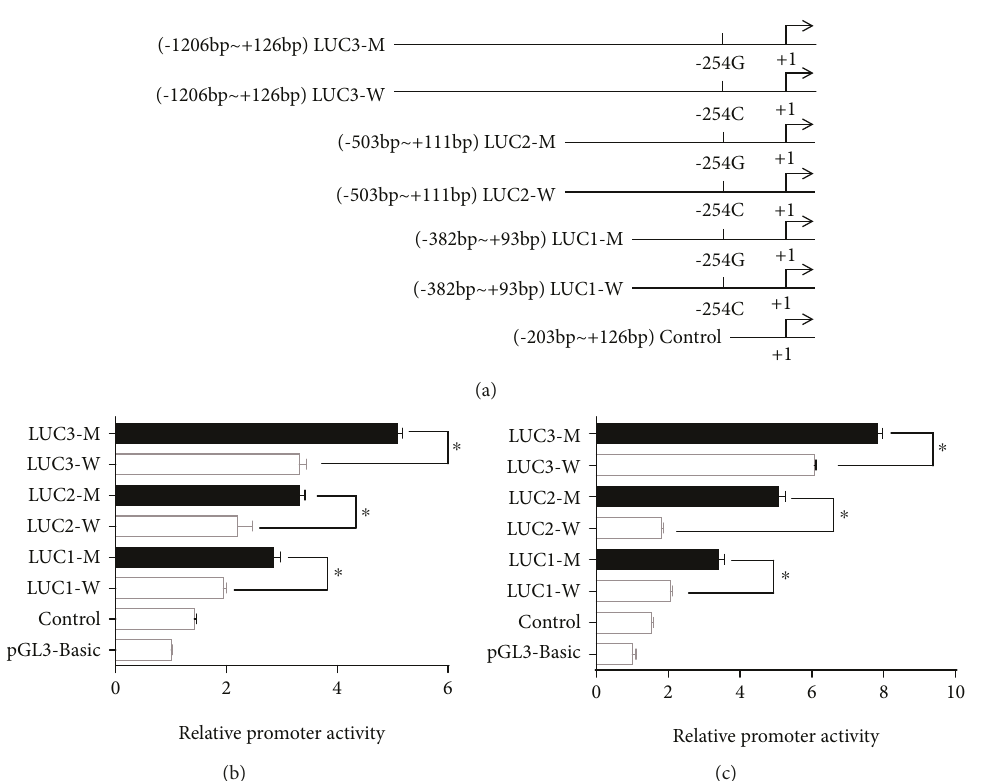
Figure 1: E ff ect of the − 254C > G SNP on TRPC6 promoter activation in podocytes and HEK 293T cells. (a) Schematic diagram of a series of plasmids used for the promoter assay. 1332 bp DNAs from the TRPC6 promoter region containing the − 254C or G allele were subcloned into luciferase expression plasmids (shown as LUC1, LUC2, and LUC3), and the control was a sequence without a − 254 site. The transcription start site is denoted by +1 and indicated by a horizontal arrow. (b and c) The − 254G allele (LUC1/2/3-M) signi fi cantly enhanced the TRPC6 promoter activation. Podocytes (b) and HEK 293T cells (c) were transfected with the di ff erent pGL3 plasmids (LUC1-W/M, LUC2-W/M, LUC3-W/M, control, and pGL3-basic), and the luciferase activities were determined in the cell transfection studies. The results were expressed as the ratio of fi re fl y to Renilla luciferase activity of quadruplicate cultures, representative of three experiments. ∗ P < 0 01 ; luciferase activity of LUC1/2/3-M compared with that of LUC1/2/3-W, respectively.